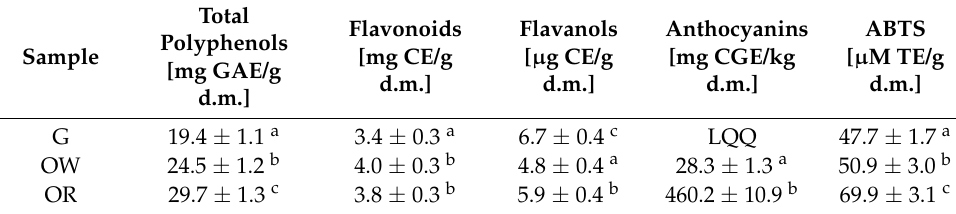
Table 1. Bioactive compounds (total polyphenols, flavonoids, flavanols, and anthocyanins) contents and antioxidant activity (ABTS) of plants from the Alliaceae family (garlic, white onion, and red onion). Total Flavonoids Flavanols Anthocyanins ABTS Polyphenols [mg CE/g [ µ g CE/g [mg CGE/kg [ µ M TE/g Sample [mg GAE/g d.m.] d.m.] d.m.] d.m.] d.m.] G 19.4 ± 1.1 a OW OR 69.9 ± 3.1